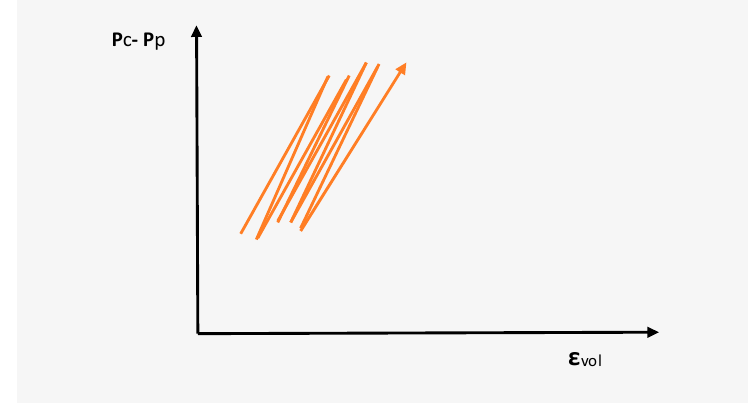
Figure 2. Variation of P c − P p vs. ε vol during a jacketed test. By using fitting techniques, the matched curve for P c − α P p versus ε vol can be obtained (Figure 3).